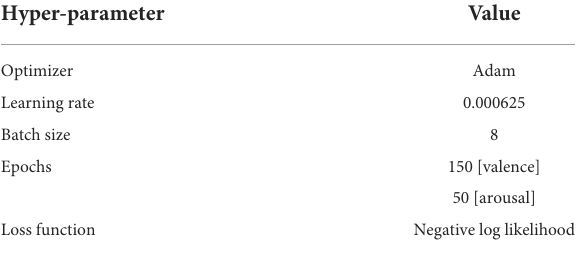
TABLE 4 Hyperparameter values of ShallowConvNet. TABLE 5 Average classification performance for different frequency bands using all channels.